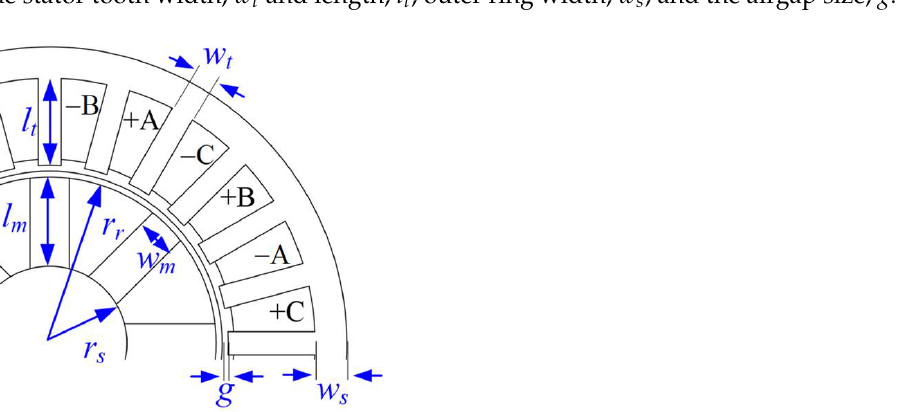
Table 1. Optimization decision variables. Figure 8. Interior permanent magnet synchronous machine model geometry for optimization, defined by the presented dimensions (labeled in blue) and winding layout (labeled in black).